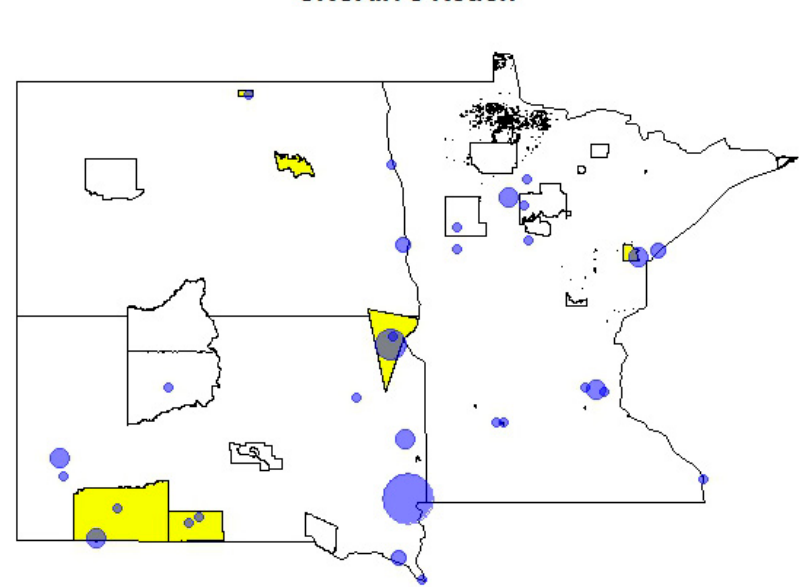
Figure 2. CRCAIH partners and regional collaborations. Bubble size is proportional to the number of collaborations.